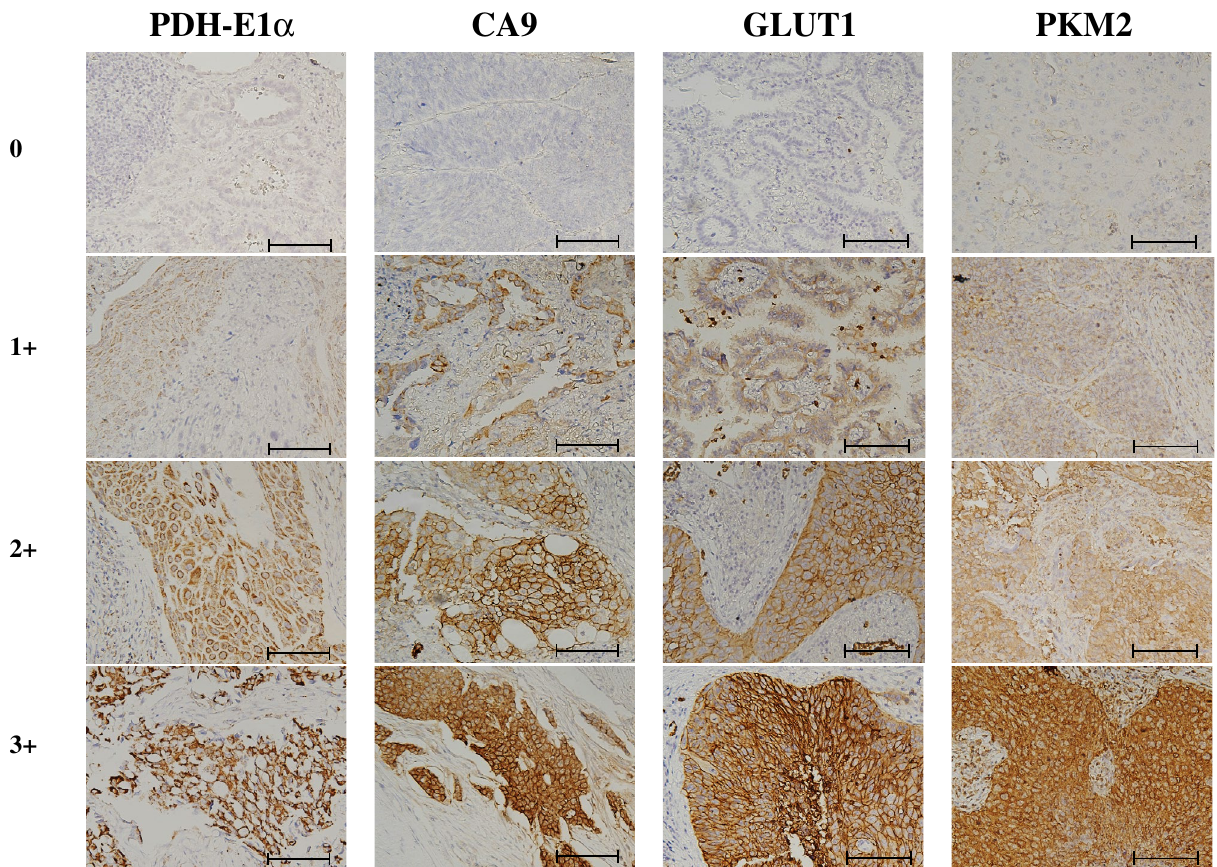
Figure 1. Immunostaining of PDH-E1α, CA9, GLUT1, and PKM2. The immunoreactivity of GLUT1, PKM2, PDH-E1α, and CA9 was evaluated according to the intensity staining of the cell membrane or cytoplasm of cancer cells. Immunostaining intensity score: 0, negative; 1+, weakly positive; 2+, positive; and 3+, strongly positive. Bar, 50 μm. PDH-E1α, pyruvate dehydrogenase E1α; CA9, carbonic anhydrase 9; GLUT1, glucose transporter-1, PKM2; pyruvate